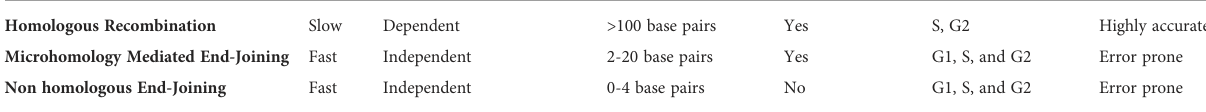
TABLE 1 Characteristics of the major double-strand breaks repair